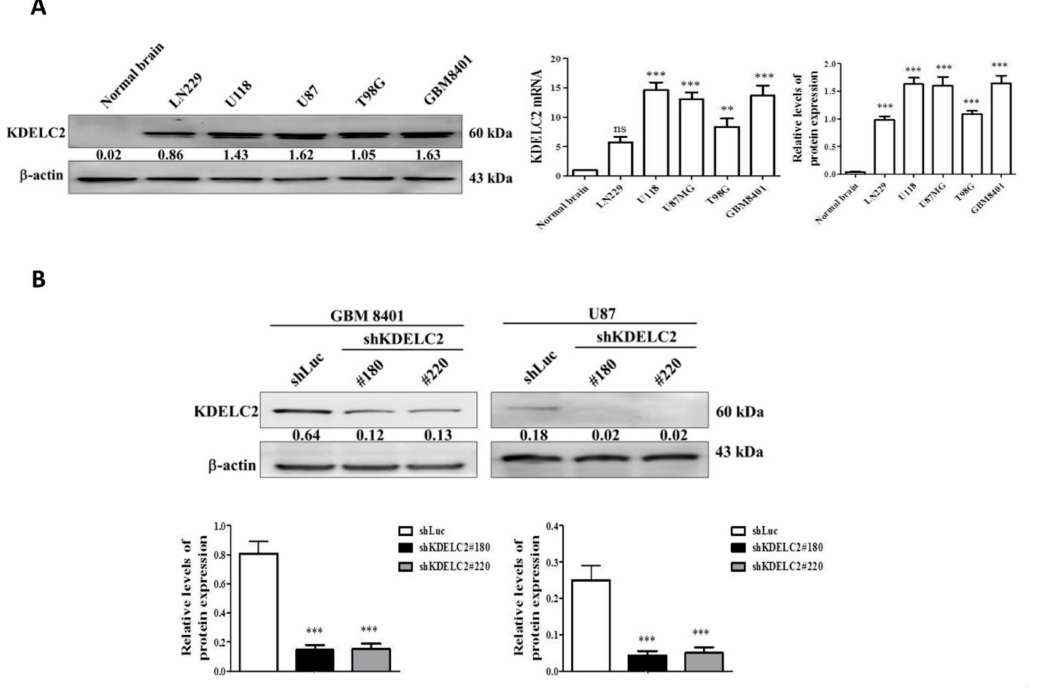
Figure2. KDELC2expressioncorrelatedwithglioblastomadevelopment. ( A )HighKDELC2mRNAand protein expression in GBM cell lines. Bars, means ± SEM. ** p < 0.01; *** p < 0.0001; p = ns, non-significant. ( B ) The shKDELC2-transfected GBM8401 and U87 suppressed KDELC2 protein